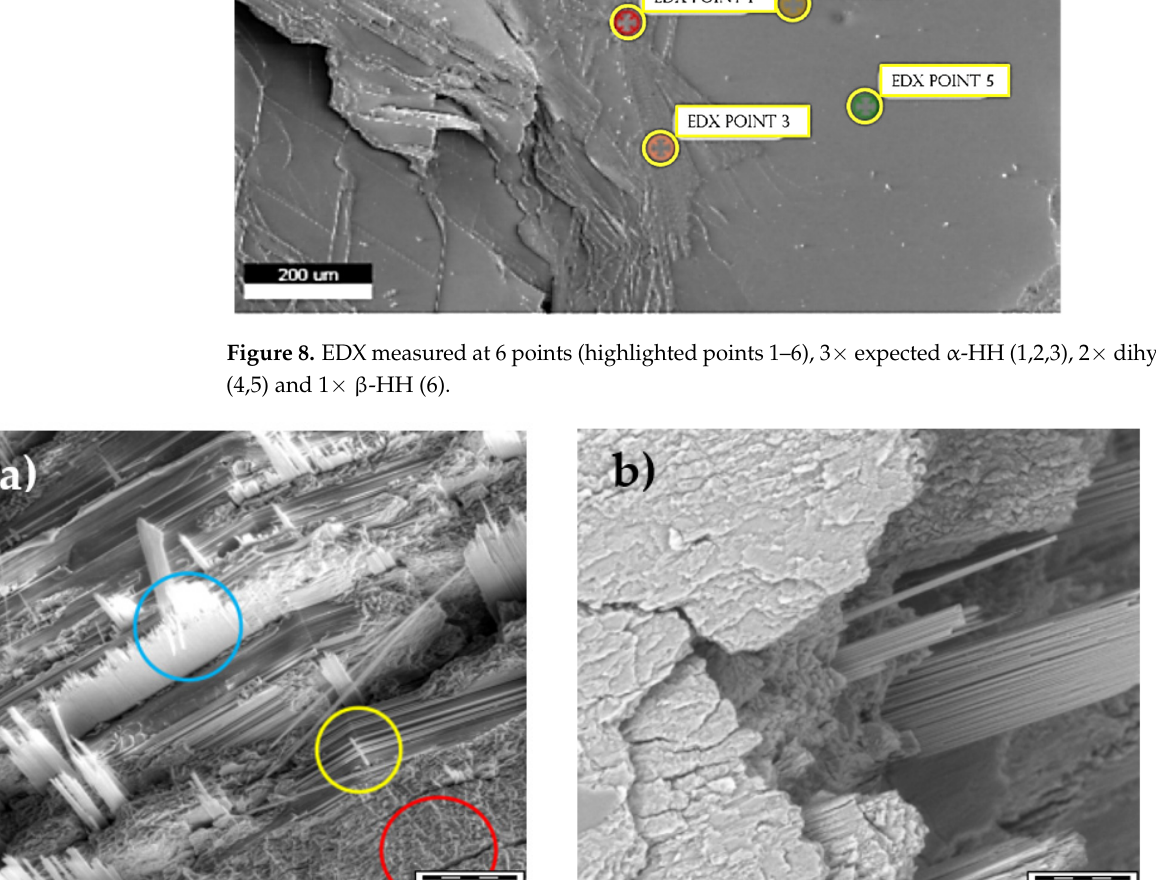
Figure 9. ( a , b ) α -HH on a broken gypsum crystal (in direction of c-axis of the original dihydrate crystal).